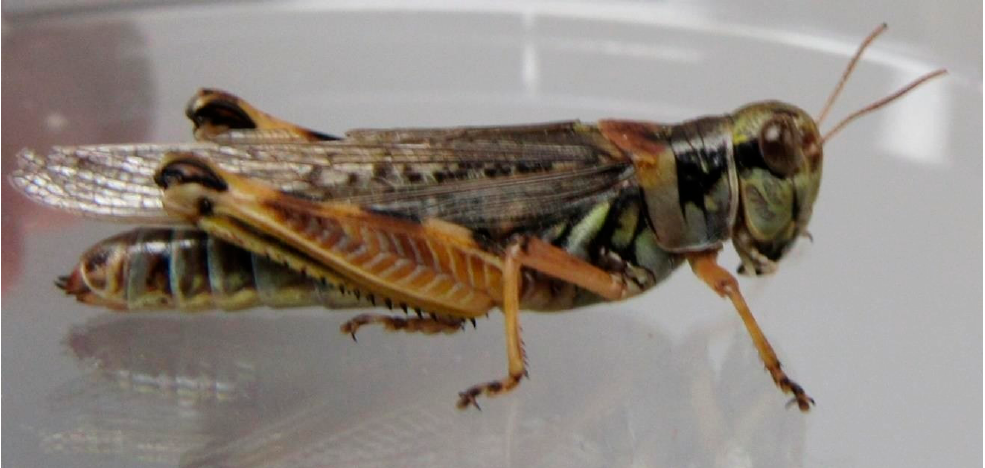
Figure 1. Female Melanoplus sanguinipes grasshopper. (Wahid Dakhel, 2014). University of Wyoming, Laramie, WY, USA. Insects 2020 , 11 , x FOR PEER REVIEW